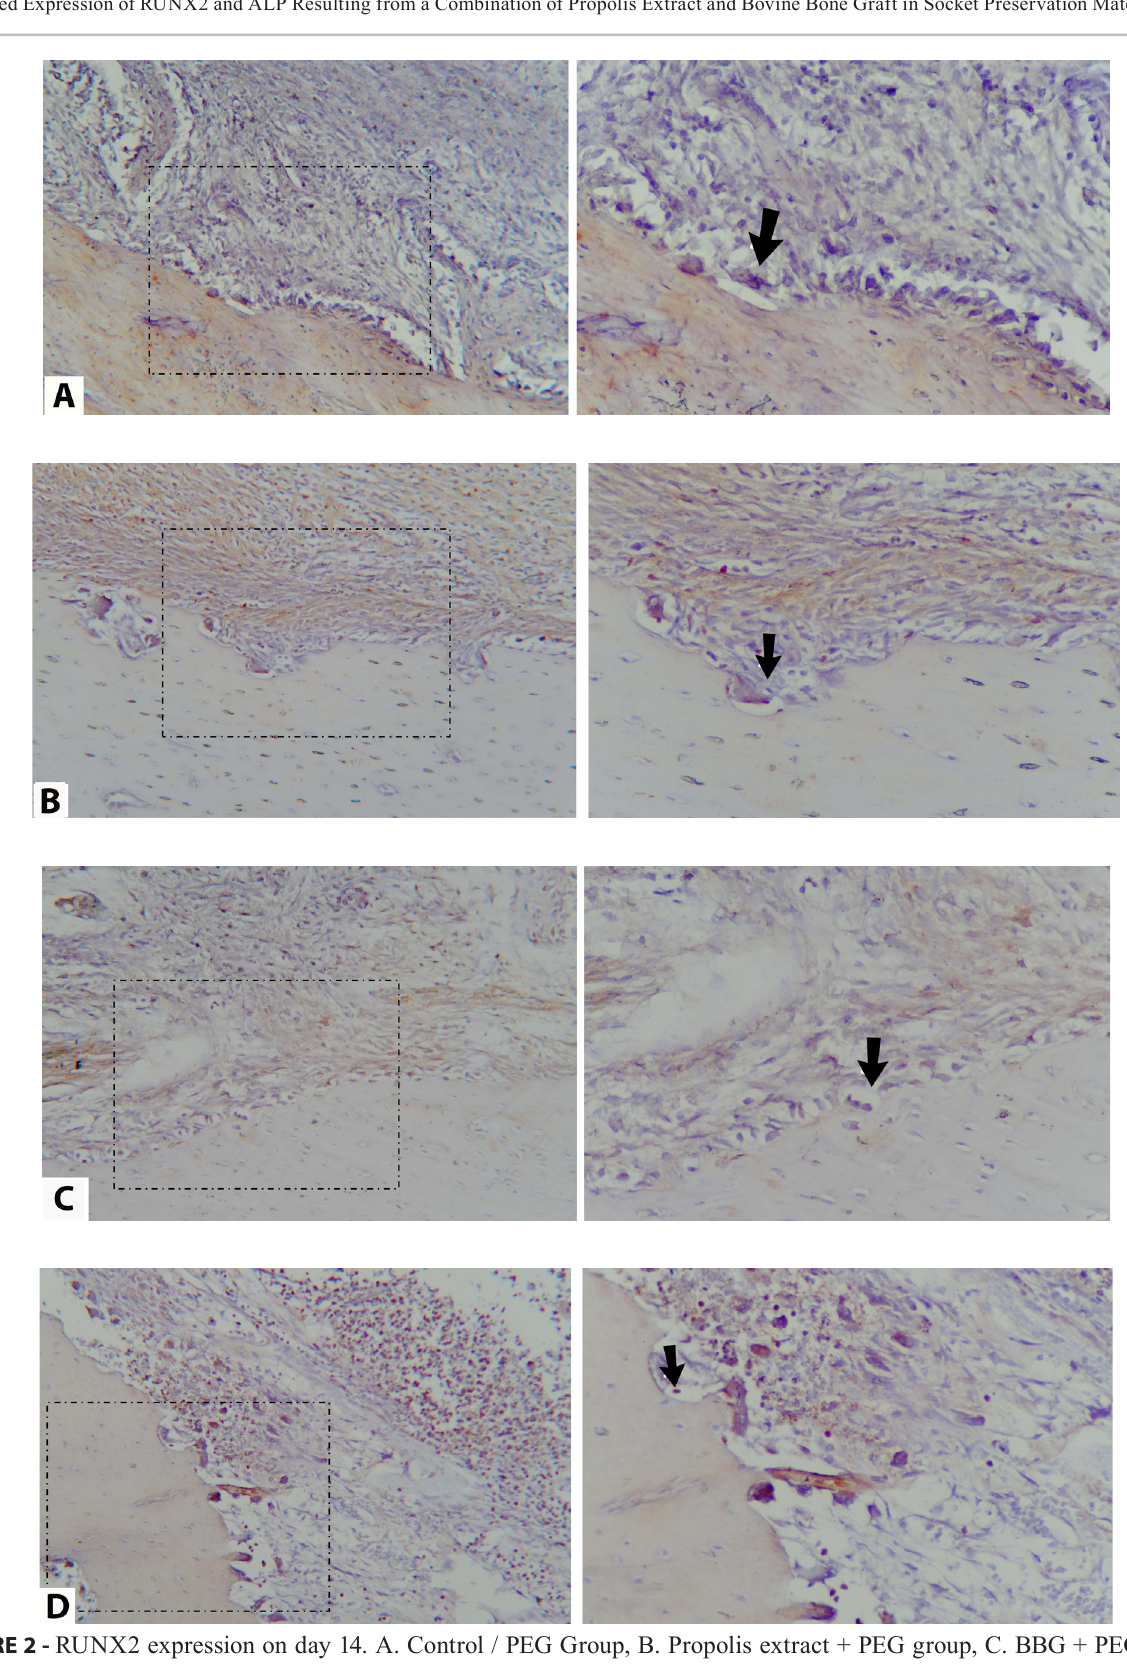
FIGURE 2 - RUNX2 expression on day 14. A. Control / PEG Group, B. Propolis extract + PEG group, C. BBG + PEG group, D. Propolis extract + BBG + PEG group. Each figures consist of 100x and 400x magnification. The arrows showed cell with positive expression of